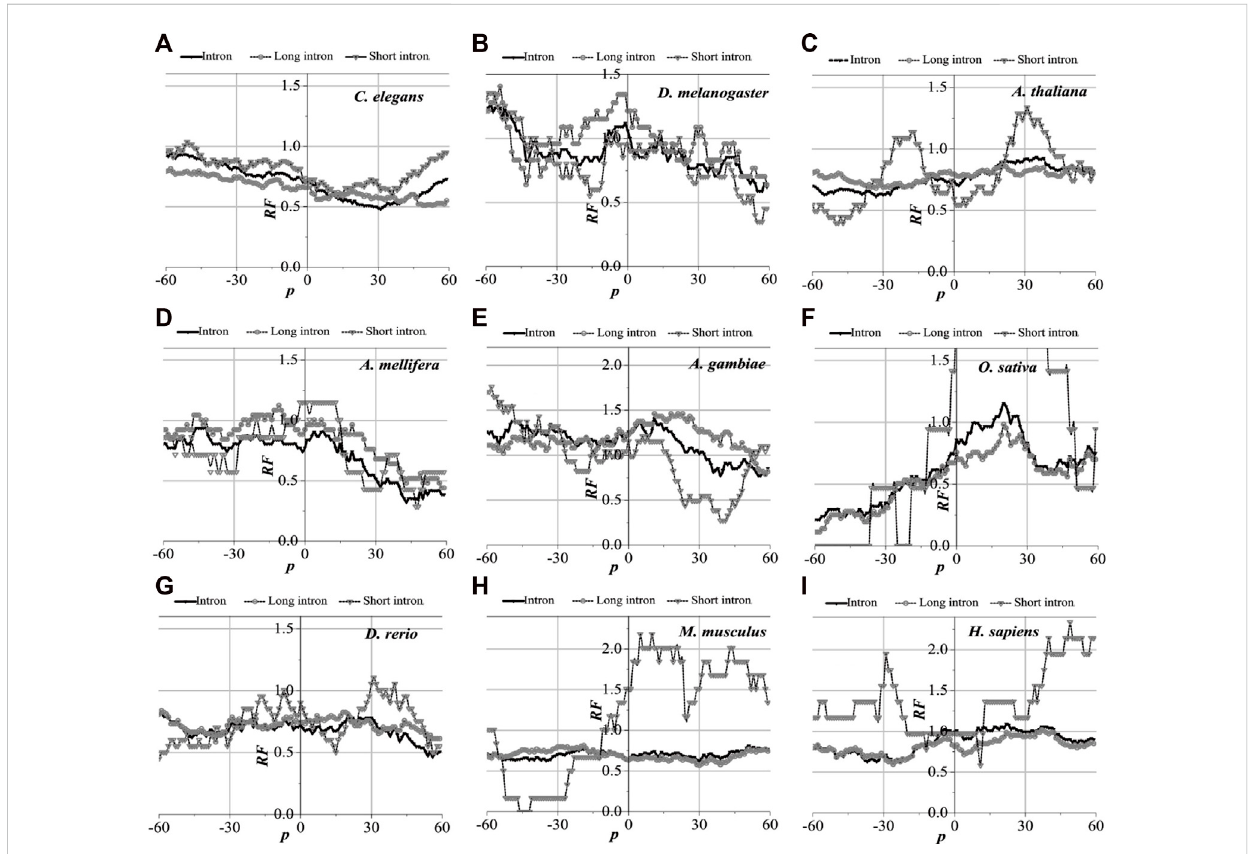
FIGURE 6 RF distributions around the fi rst exon junction site. The X-axis is the position of mRNA and the Y-axis represents the RF values. RF = 1 represents the average value of relative match frequencies